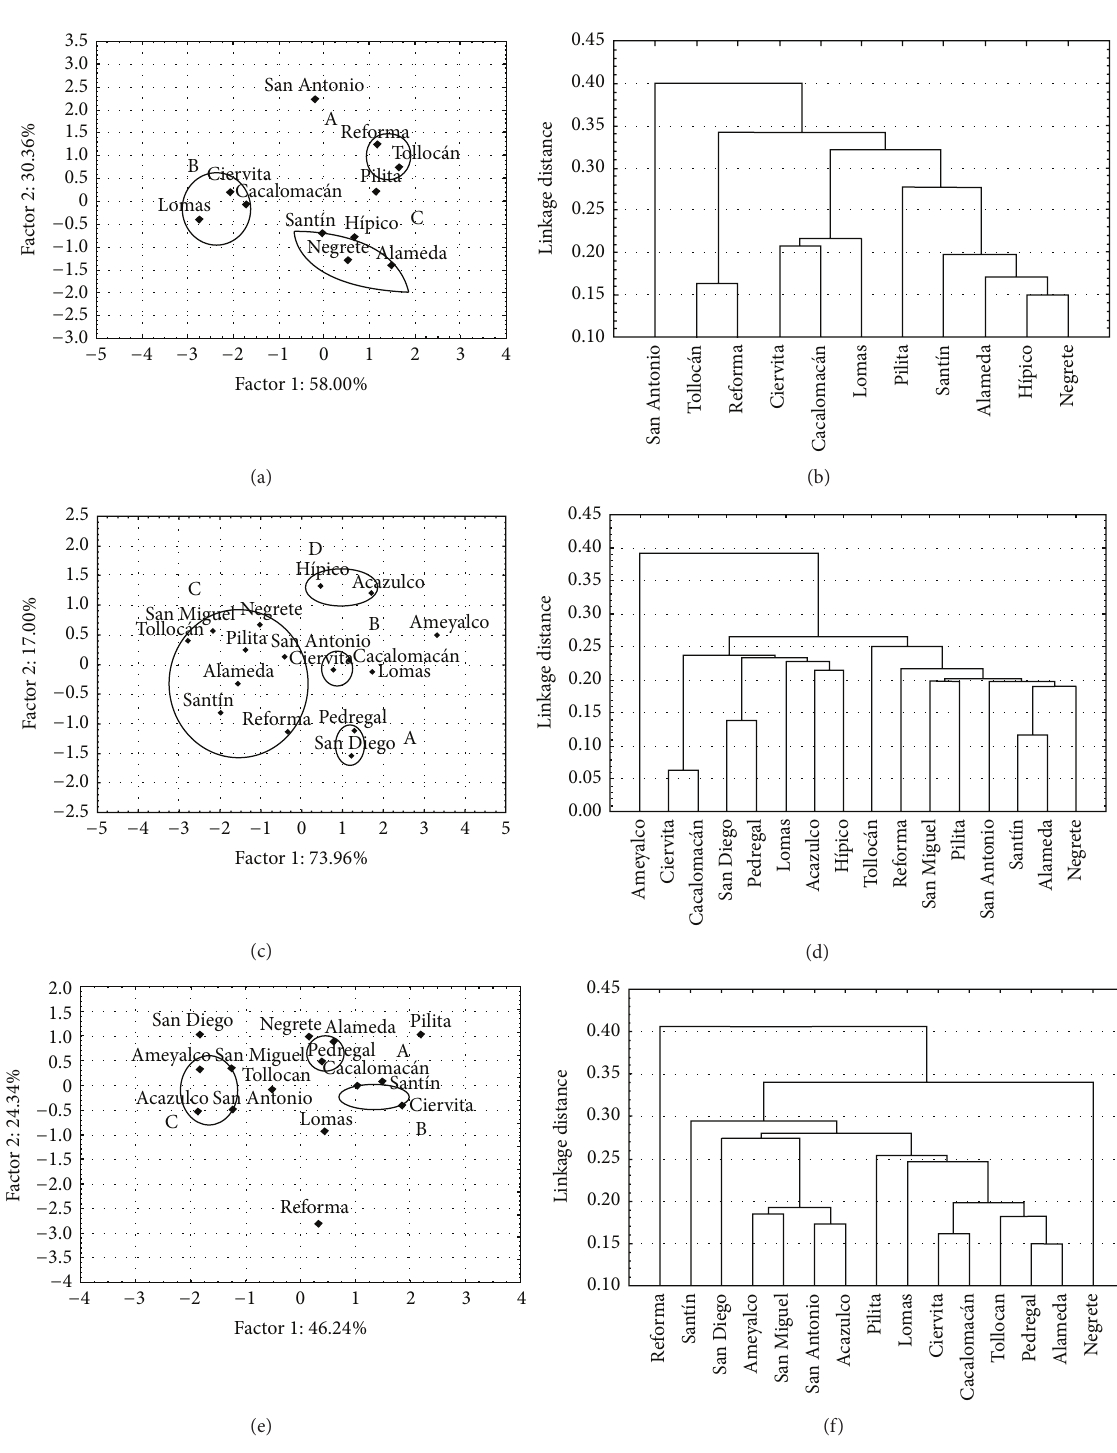
Figure 3: Analysis of the elements (Se, Hg, Cr, and As). Mosses samples (autumn): (a) and (b); mosses samples (summer): (c) and (d); topsoil samples: (e) and